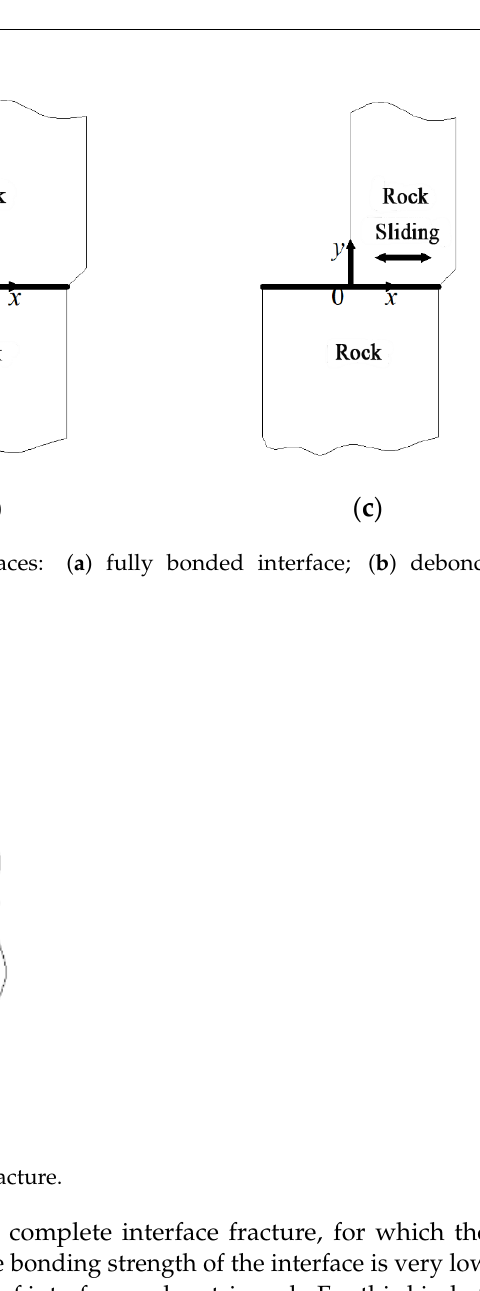
Figure 2. Four types of interfacial fracture.